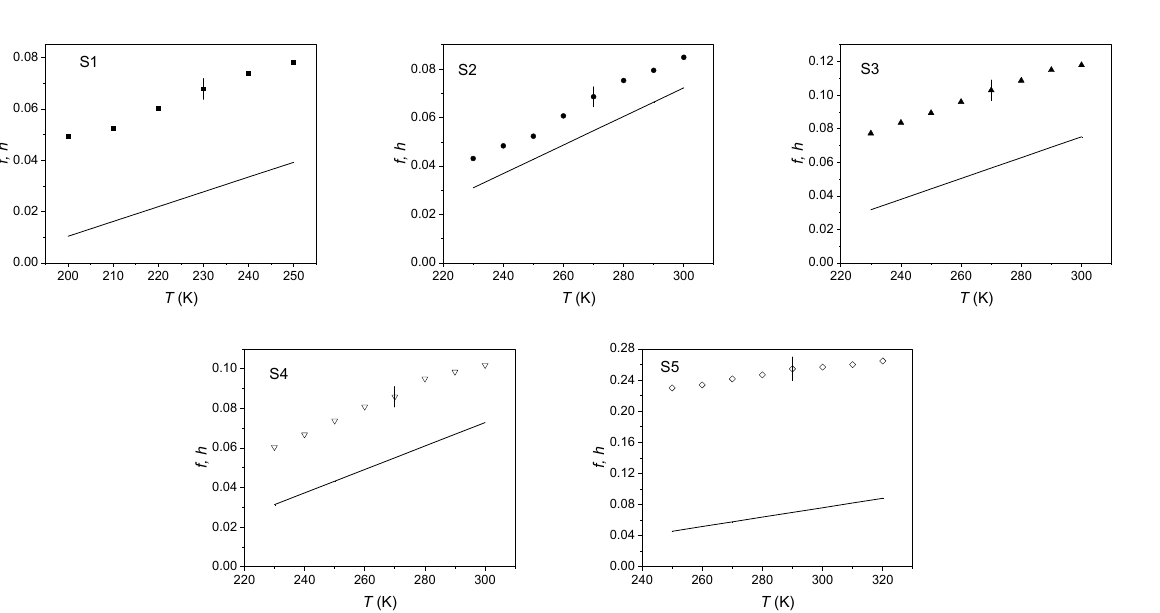
Figure 4. Specific volume versus the average hole volume in the investigated elastomers (S1: squares, S2: circles, S3: filled triangles, S4: empty triangles, S5: empty diamonds). Uncertainties for V sp are within the size of the symbol; typical uncertainty for v h is shown as a bar. Correlation coefficient was >0.993 for all curves, which implies that the number density of holes, N in Equation (2) can be considered constant in the investigated range of temperatures. Its numerical values are shown in Table 2. Table 2. Number density of holes, N , in the investigated elastomers using the spherical approximation. Typical uncertainty is 6%. S1 S2 S3 S5 S4 N 10 21 (g − 1 ) 0.574 0.528 0.747 0.643 1.744 Knowledge of N was used to evaluate the free volume fraction f , as supplied by PALS and dilatometry (Equation (3)) and to compare it with the analogous quantity h provided by the theory. The results are shown in Figure 5.